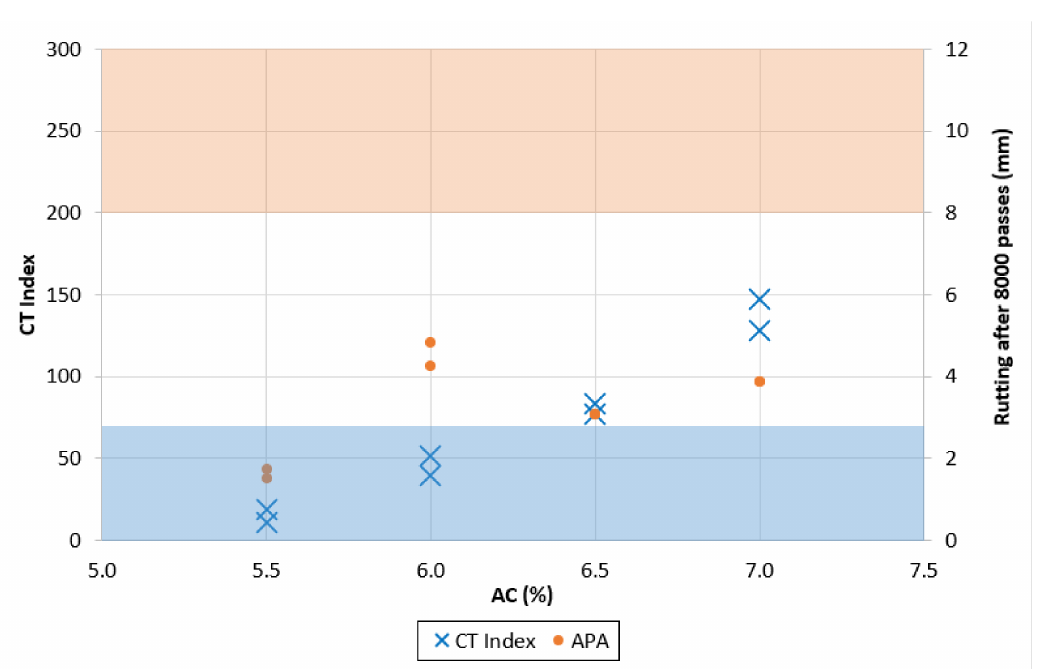
Figure 5. Performance tests on mix